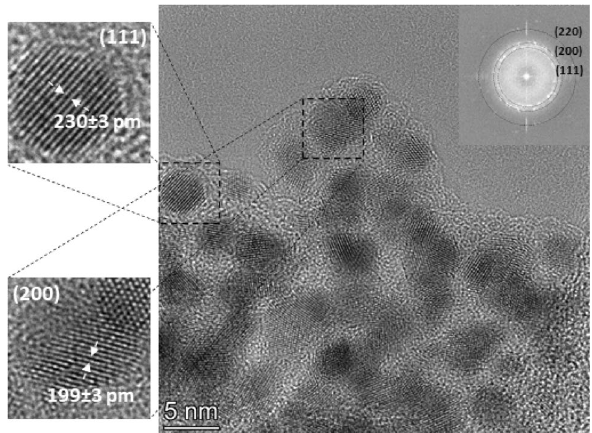
Figure 3. TEM micrograph of a typical aggregate of Au/Co BNPs (generated at 1.0 Ω circuit resistance), with close-ups of two different crystalline particles (on the left of the main image), showing the value of average lattice spacing obtained from the given region. The Fourier transform of the TEM micrograph of the whole aggregate is shown in the upper right corner of the